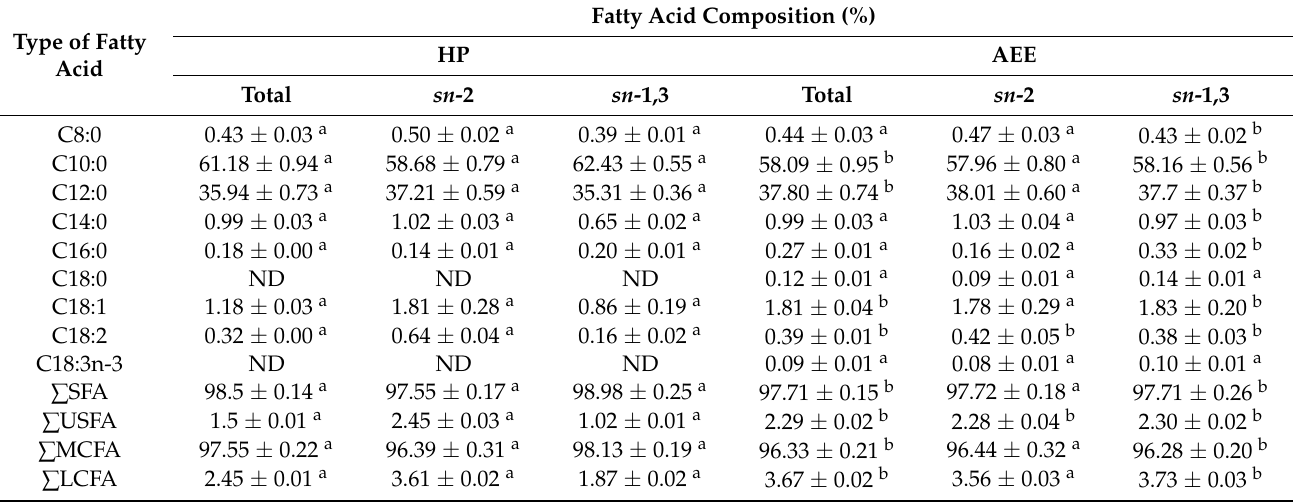
Table 1. Fatty acid composition of CCSKO.